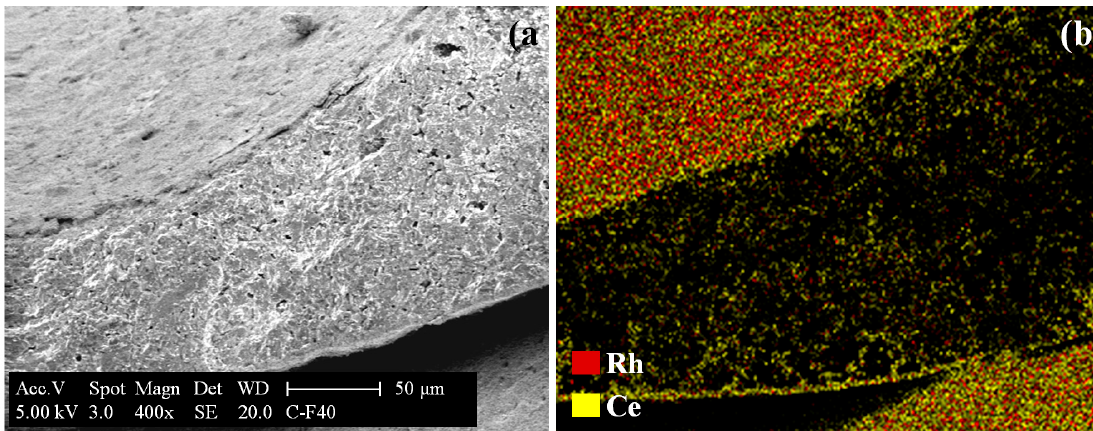
Figure 3. Scanning electron microscopy (SEM) micrographs at different magnification of the Rh/CeO 2 -coated F20 ( a , b ), F30 ( d , e ) and F40 ( g , h ) structures and corresponding EDX mapping ( c , f , i ).